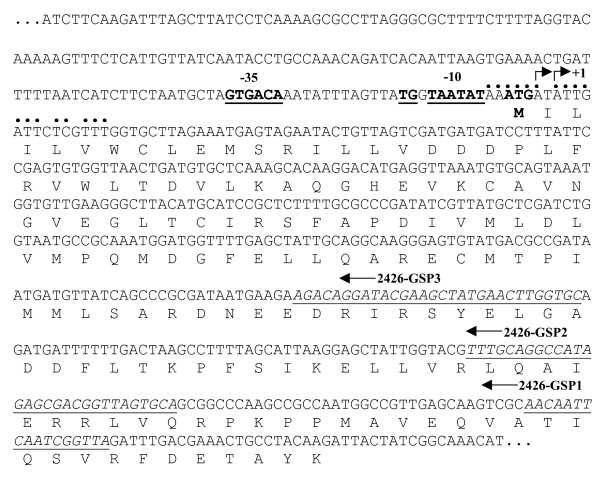
Nucleotide sequence of the so2426 promoter region and N-terminal coding region. The transcriptional start site (+1) is indicated by arrows, and putative -10 and -35 basal promoter elements are presented in boldface and underlined. Closed circles indicate conserved residues matching a predicted Fur-binding recognition site. The annotated (original) translation start codon (M1 residue) of so2426 is shown in boldface. 5'-RACE results described here indicate that the annotated translation start codon is incorrect, and residue M11 constitutes the actual start codon. The 5'-RACE primers used to identify the transcription start site are shown in italics and underlined.